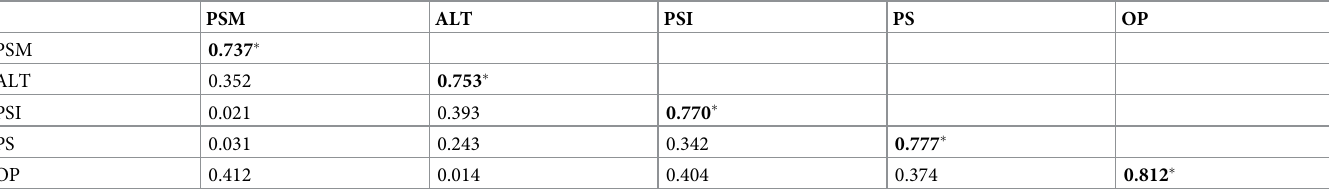
Table 4. Discriminant validity.